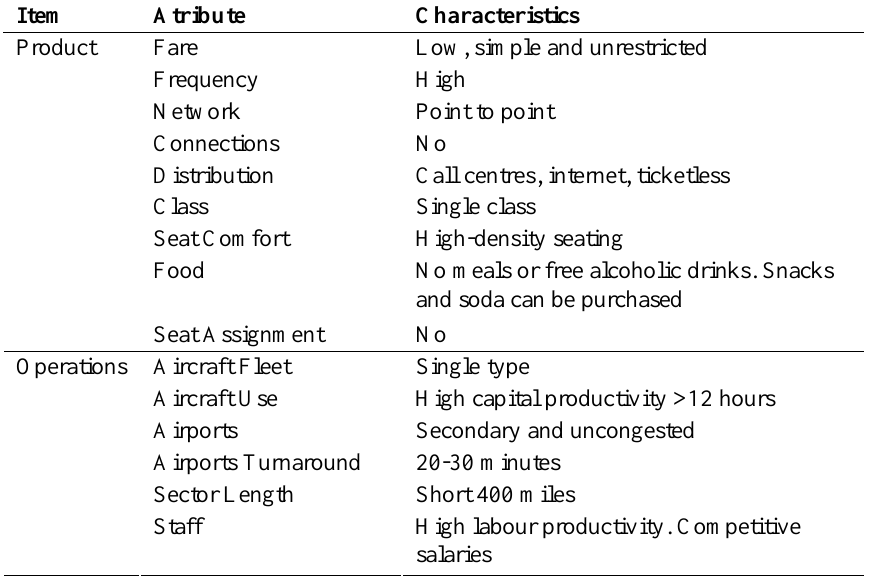
Table 1. Original Low-cost carrier business